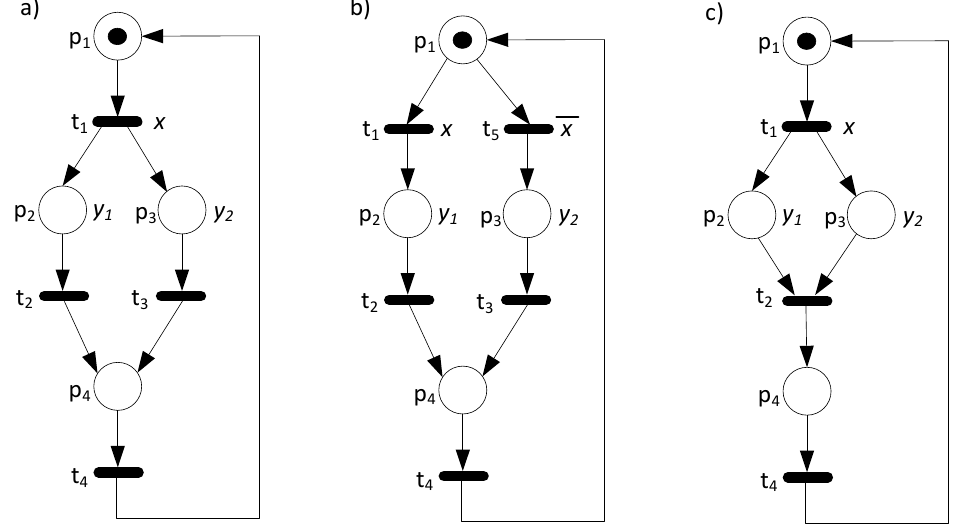
Figure 2. An unbounded CPS (fork-join) ( a ), and its corrected: 1st version ( b ), and 2nd version ( c ).